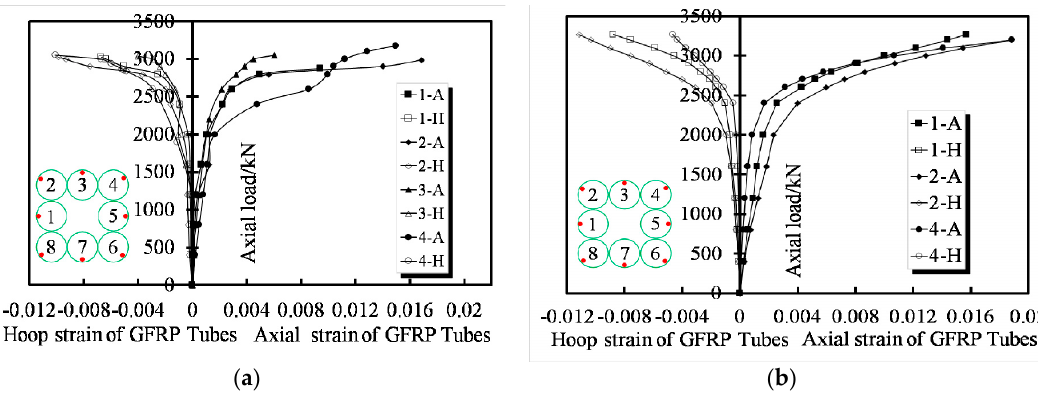
Figure 7. Typical load–strain response of GFRP tubes: ( a ) specimen T8N-1 and ( b ) specimen T8N-2.